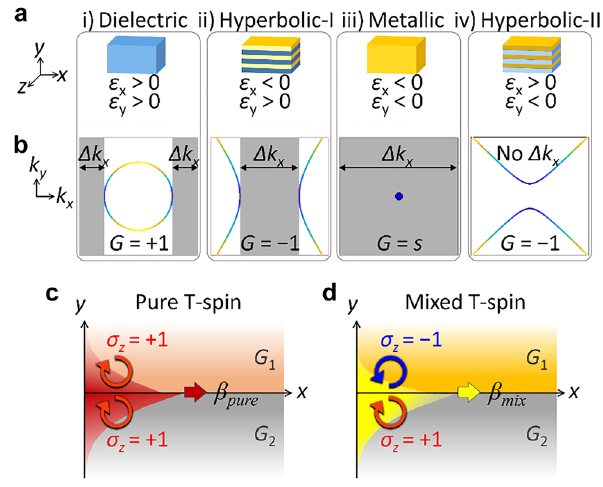
Figure 1: Topology and gap of